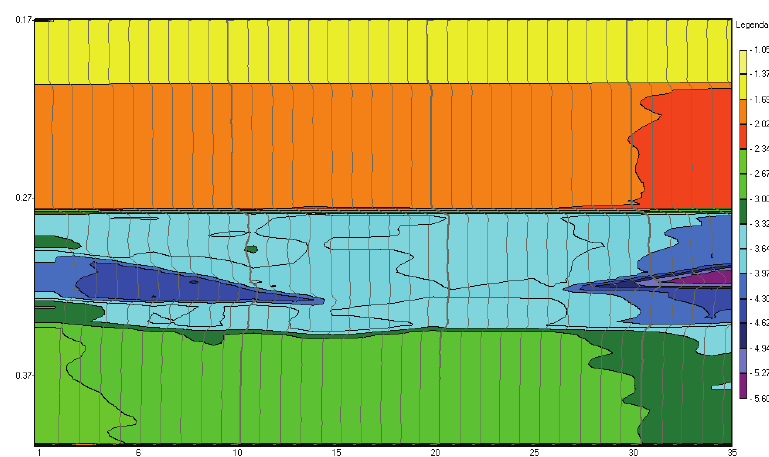
Fig. 7. Synthetic pseudoimpedance acoustic section with predictive deconvolution; signal parameters: dominant frequency f 0 = 40 Hz, initial phase φ 0 = 0, the ratio of dominant frequency to dumping factor f 0 / β =2, noise